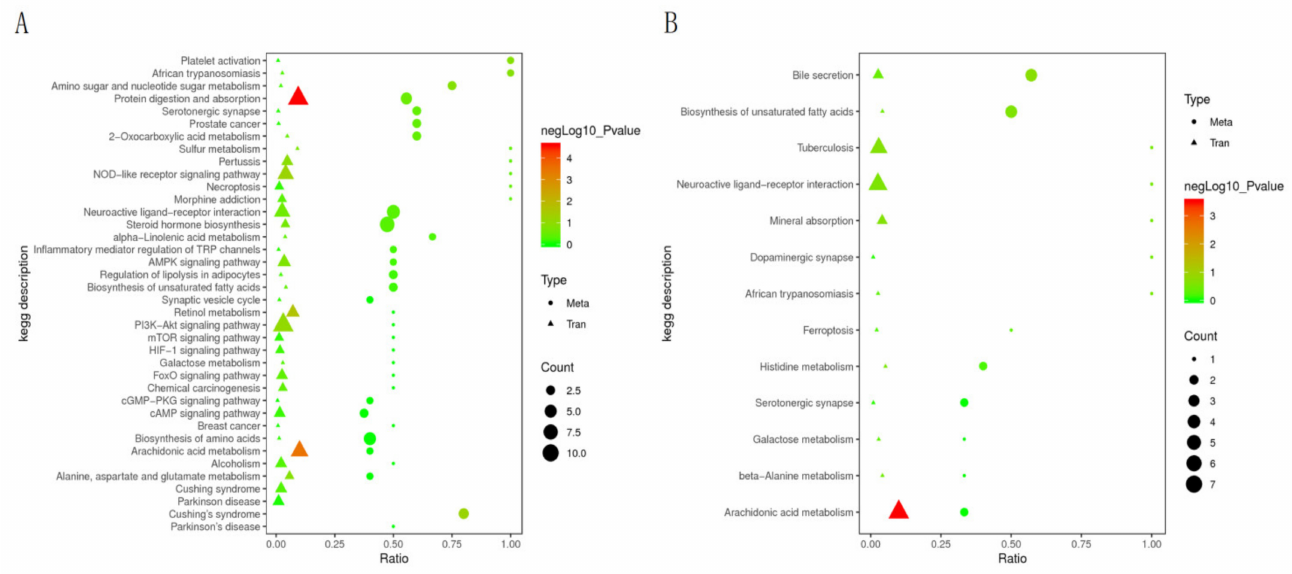
Figure 12. KEGG enrichment analysis of DMs and DEGs. Positive DMs ( A ), negative DMs ( B